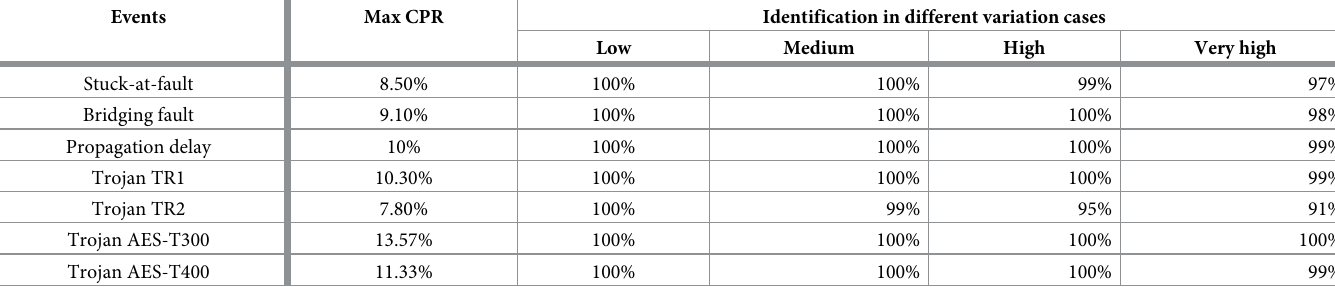
Table 3. Faulty AES chip identification for different faults and Trojans under low, medium, high and very high variation cases.